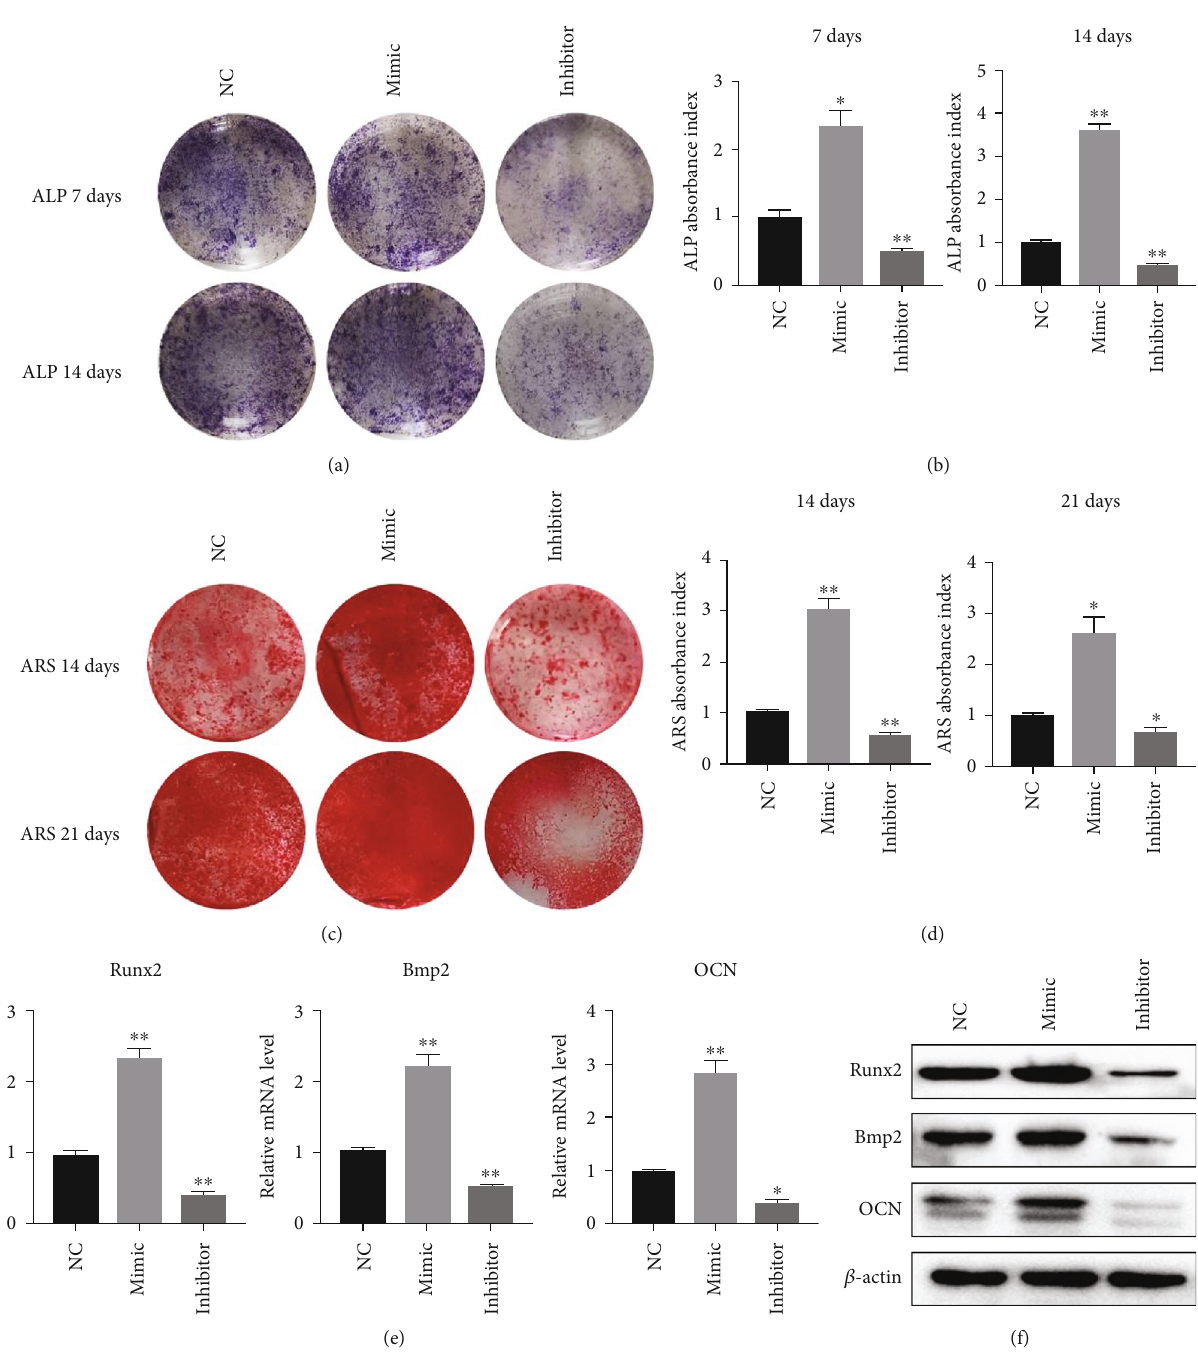
Figure 3: miR-129-5p promoted osteoblast di ff erentiation of BMSCs. BMSCs were transduced with a lentiviral vector containing miR-129-5p mimic, miR-129-5p inhibitor, or negative control (NC) lentivirus, respectively. 48 hours after transduction, cells were cultured in osteoblast induction medium. ALP staining was performed at days 7 and 14 following induction (a); corresponding ALP absorbance index was calculated (b). ARS staining of BMSCs was performed at days 14 and 21 following induction (c); corresponding ARS absorbance index was calculated (d). mRNA (e) and protein (f) levels of osteoblast-related genes Runx2, Bmp2, and OCN were detected by quantitative RT-PCR and western blot, respectively. β -Actin was used as an internal control. All data were expressed as means ± SD . ∗ p < 0 : 05 and ∗∗ p < 0 : 01